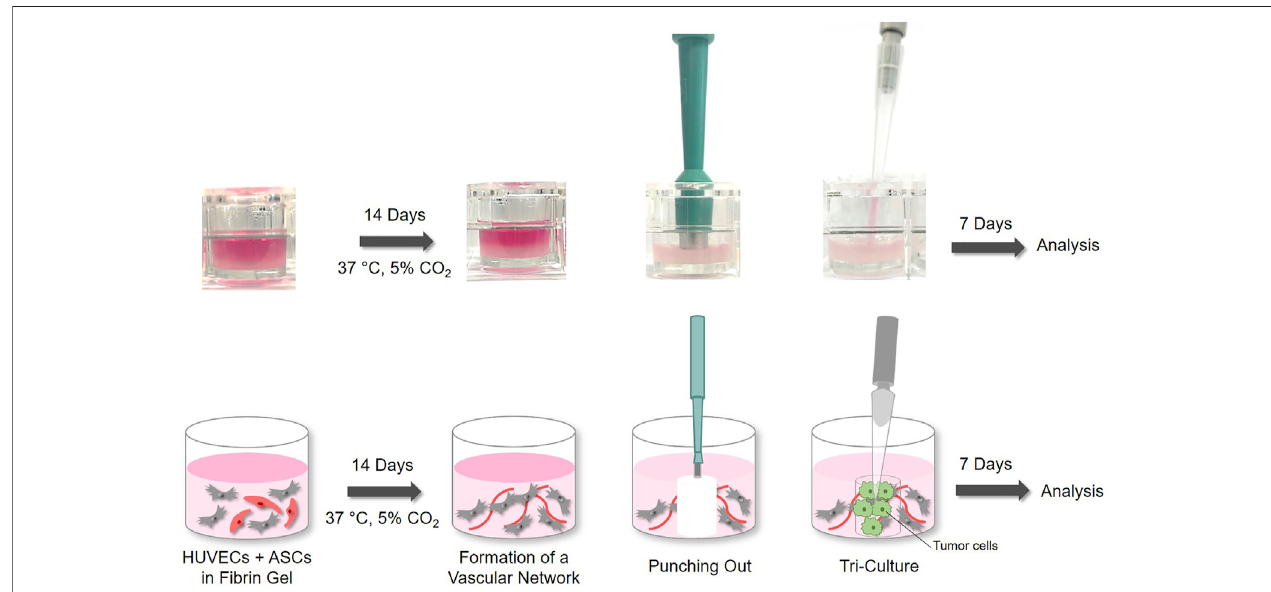
FIGURE 1 | Experimental Set-up: HUVECs and ASCs were moulded in a fi brin gel and cultured for 14 days at 37 ° C and 5% CO 2 . To form tri-cultures, the central part of the gel was punched out and replaced by fi brin gel containing A549 cancer cells.